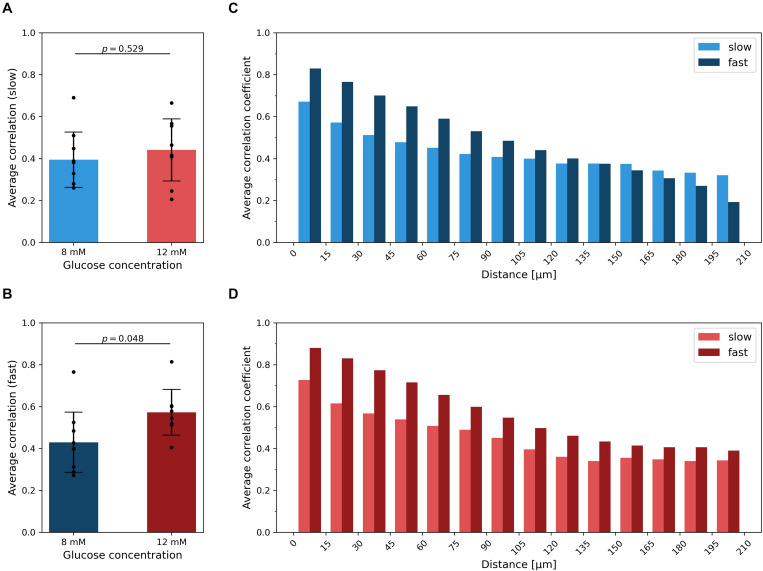
Intercellular synchronicity of slow and fast oscillatory beta cell activity. The average correlation coefficient between the slow (A) and fast (B) oscillatory components for both glucose concentrations. Black dots denote average values of individual islets, error bars reflect the standard deviation, and the column height displays the average over all islets in the given group. Cohen’s d values are 0.31 and 1.05 for average correlation of slow and fast component, respectively. In panels (C,D), the average correlation as a function of the Euclidean distance between cell pairs is shown for 8 mM (C) and 12 mM (D) glucose, separately for each dynamical component. The heights of the columns represent the average over all cell pairs in all islets belonging to a certain spatial interval.